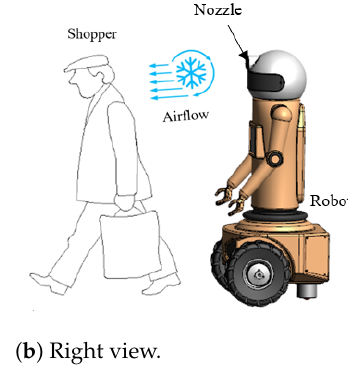
Figure 18. The airflow behavior around the shopper. We designed many different air outlets; each has different air directions to vary the air angle and intensity. The 3D-printed nozzle is mounted on top of the robot air conditioner, as shown in Figure